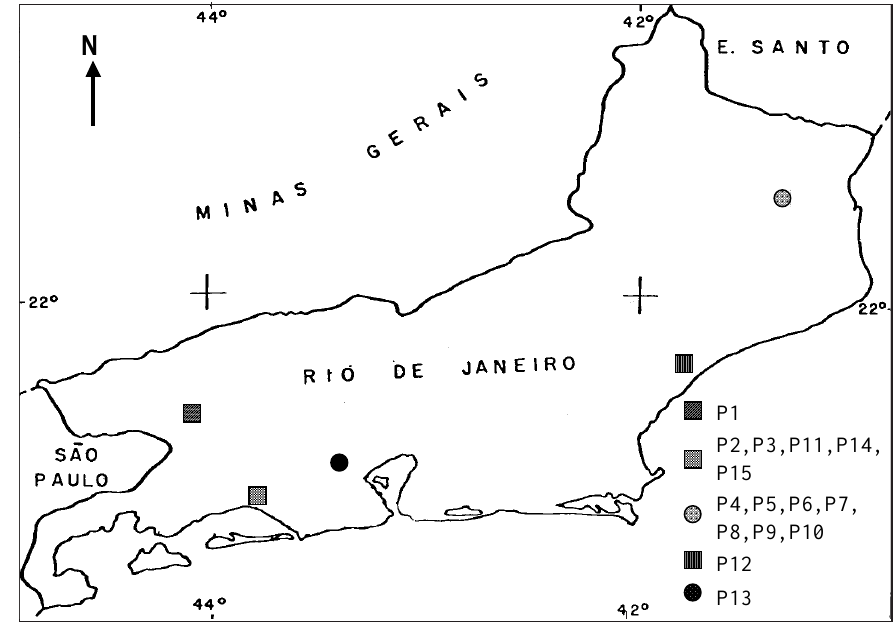
Figura 1. Localização aproximada dos perfis estudados no estado do Rio de Janeiro.